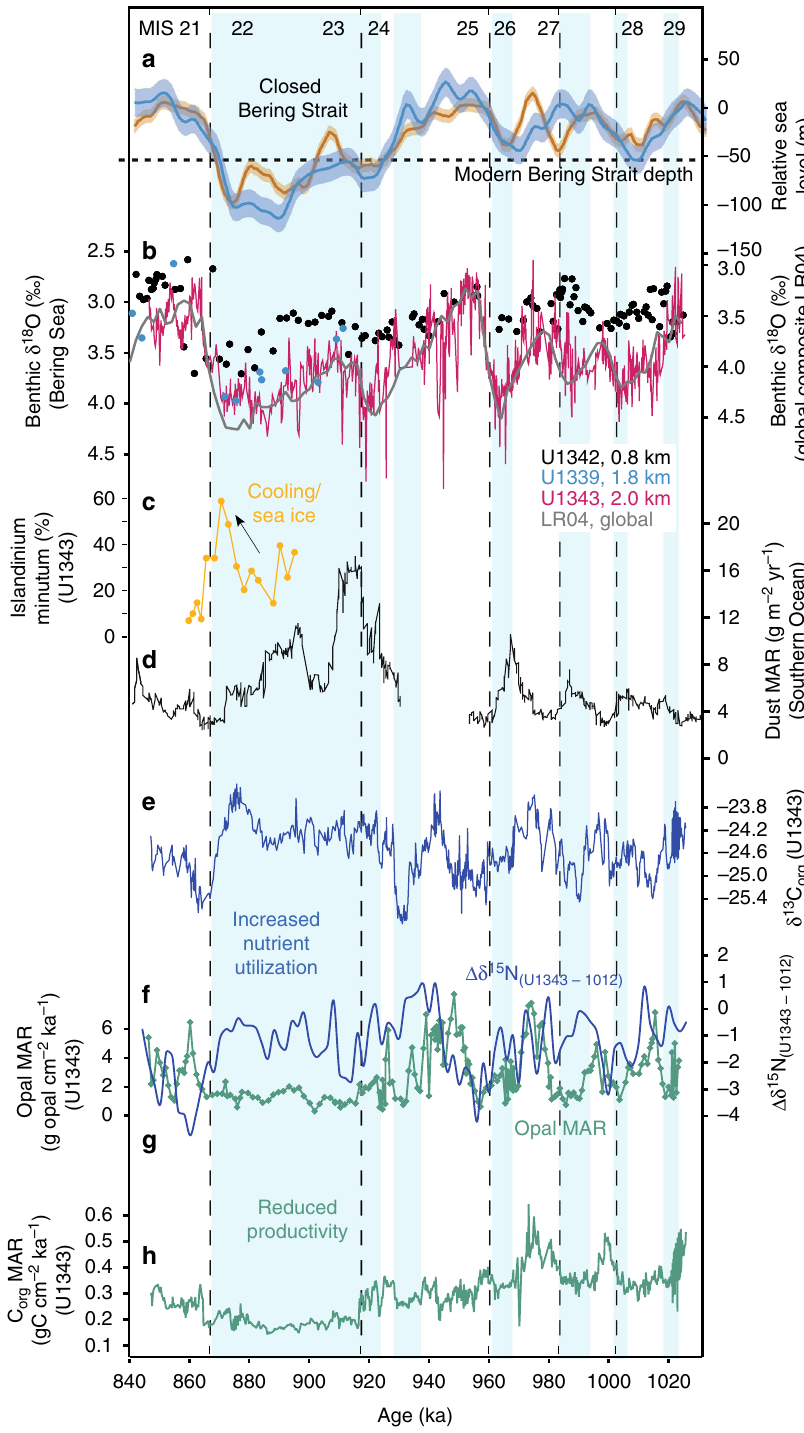
Fig. 3 Proxy data from Site U1343 for the time interval 850 – 1020 ka. Vertical blue bars are times of reduced productivity and elevated nutrient utilization indicating reduced deep water nutrient upwelling along the Bering Slope. a Global sea level estimates from Site 1123 (blue) 2 and the Mediterranean (orange) 3 . The current Bering Strait sill depth is indicated with a horizontal dashed line. b Benthic δ 18 O data (this study) from U1343 (red), U1342 (black) 27 , U1339 (blue) 36 and LR04 (grey) 30 . Data from U1339 and U1342 has been converted to the Elphidium batialis scale for direct comparison with U1343 data. c Dino fl agellate cyst Islandinium minutum % data for U1343 (this study). d Dust MAR from the Southern Ocean ODP Site 1090 5 . e Bulk sediment δ 13 C org for U1343 (this study). f Bulk sediment δ 15 N for Site 1012 48 subtracted from U1343 ( Δδ 15 N). g Opal mass accumulation rate (MAR) as a proxy for productivity (green) for Site U1343 25 . h Total organic carbon (C org ) mass accumulation rate (MAR) as a proxy for productivity for Site U1343 (this